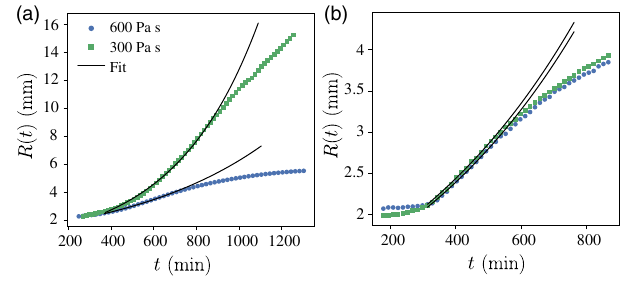
FIG. 10. (a) Colony radius as a function of time during the first day of growth for two different viscosities: blue circles, η ¼ 600 (cid:2) 90 Pa s; green squares, η ¼ 300 (cid:2) 45 Pa s; black line, exponential fit realized for t < t (cid:3) . The short-time behavior is consistent with an exponential growth of the colony radius in both cases, but the growth is much faster at lower viscosity. (b) Same as in (a) with experiments realized for colonies growing on a 1-mm-thin substrate liquid film on the top of a nutrient-rich gel layer. We find that the exponential fit realized for t < t (cid:3) exhibits a similar expansion rate for both